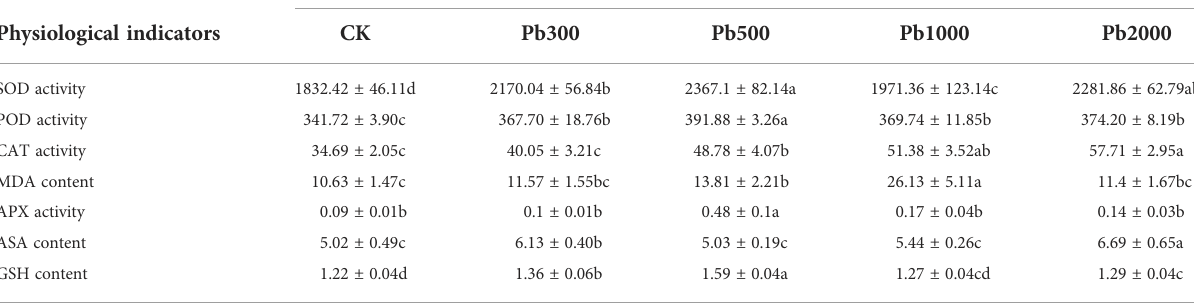
Different lowercase letters in the same row represent signi fi cant differences among different treatments (P <